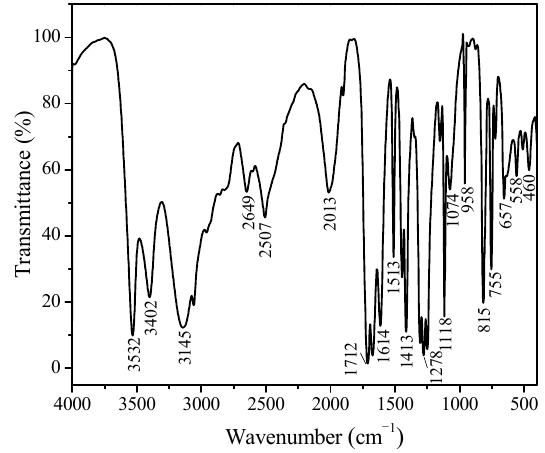
Figure 3. FTIR spectrum of the ligand H 4 btca.